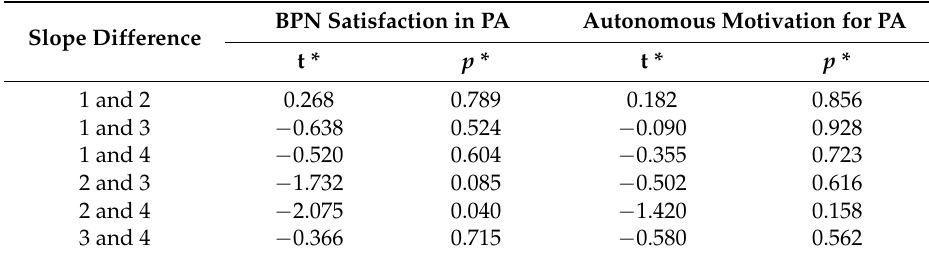
Table 3. Simple slope comparisons for the three-way interactions (autonomy support from PE teachers, father, and peers) of BPN satisfaction in LTPA and autonomous motivation for